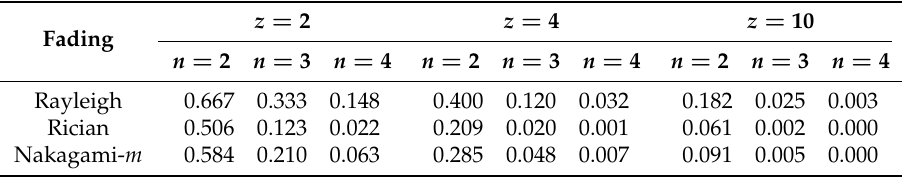
Table 1. Capture probabilities under different fading channels for z = 2,4,10. ( K = 3, m =